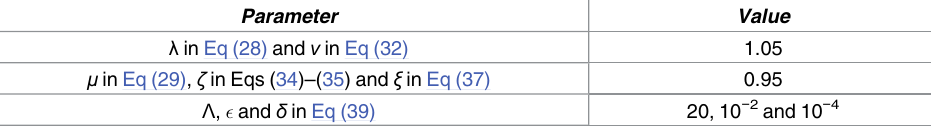
Table 2. Pumping management parameters.